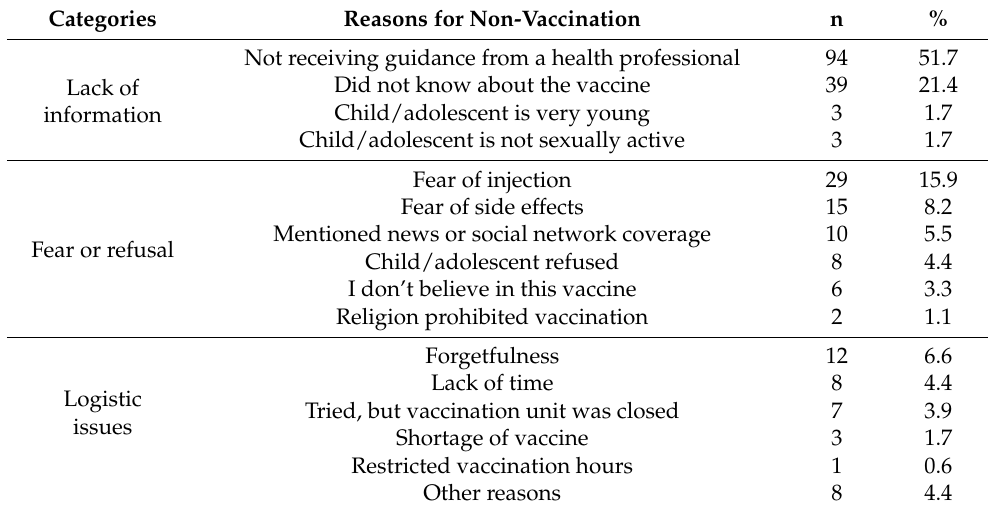
Table 2. Reasons for non-vaccination against HPV by parents or guardians of unvaccinated children and adolescents (n = 182).